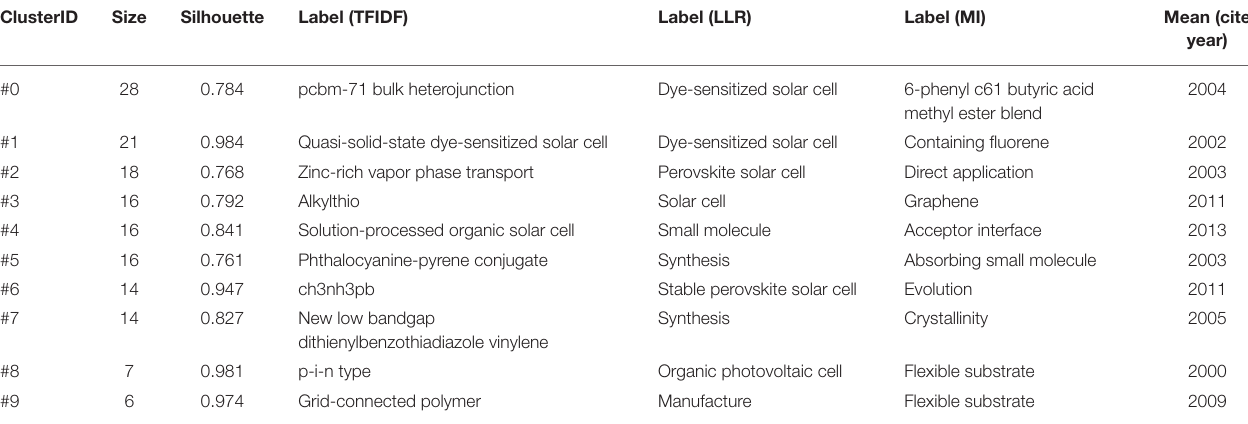
TABLE 3 | Top-ranked clusters in OPV field. ClusterID